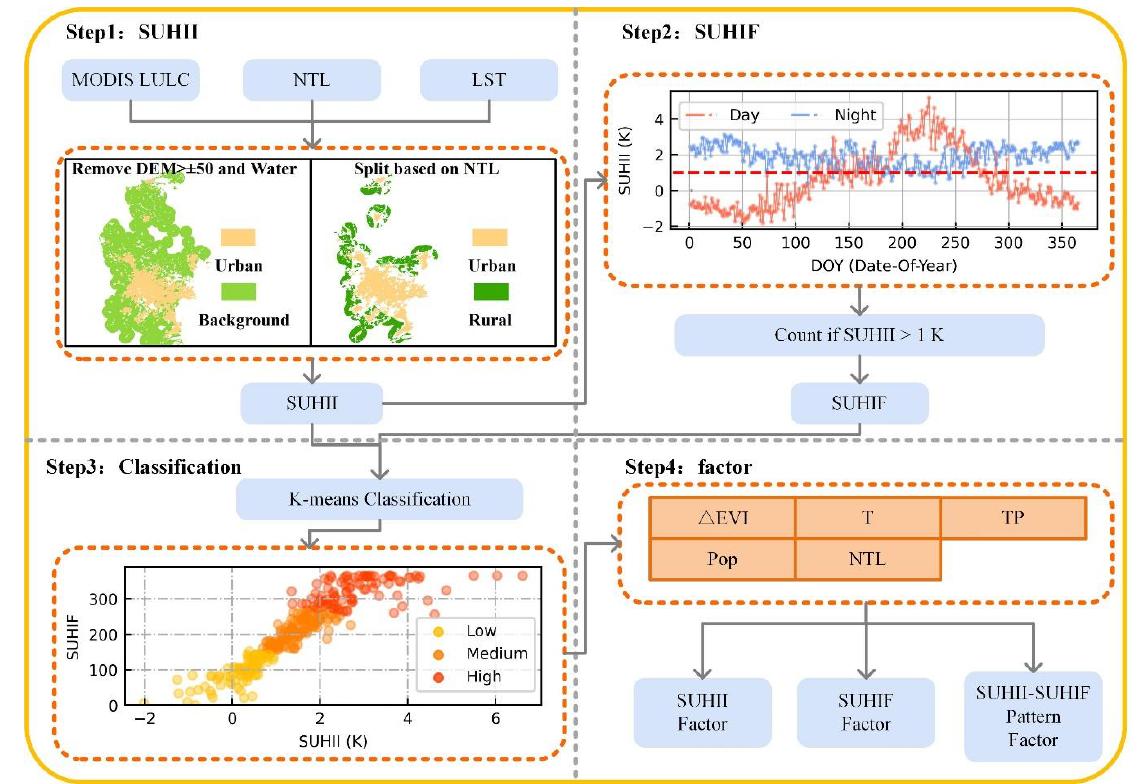
Figure 2. Flowchart of this study. There are four steps, including SUHII calculation, SUHIF estimation, pattern classification and factor analysis. To make it clear, Tianjin is taken as an example in the flowchart.